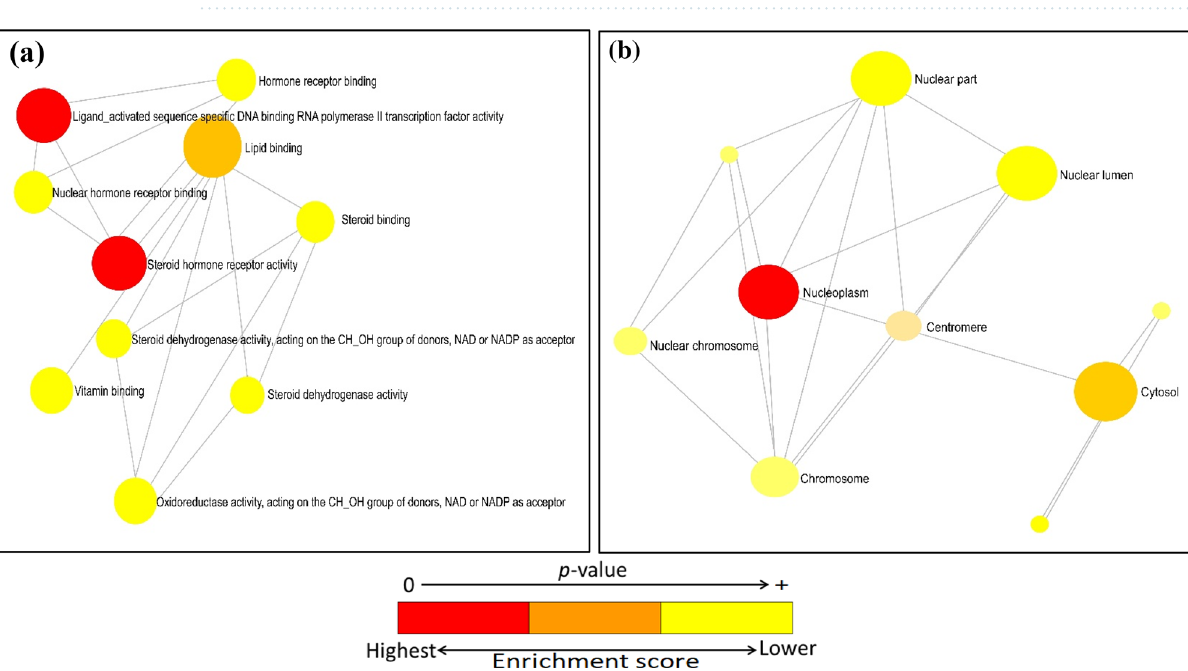
Figure 4. ( a ) Bar graph of top ten enriched biological processes ( b ) Drug-target-biological process network constructed by cytoscape highlighted top ten BP and their linked genes.